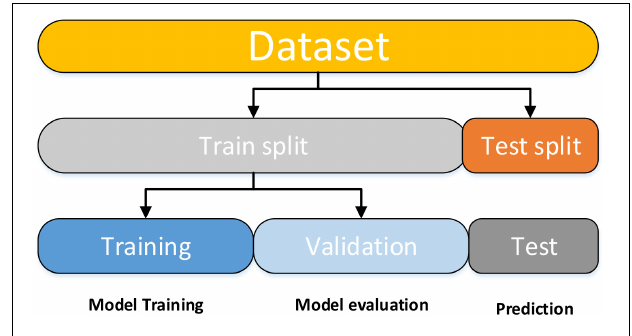
FIGURE 3 | The data splitting stage is depicted in a